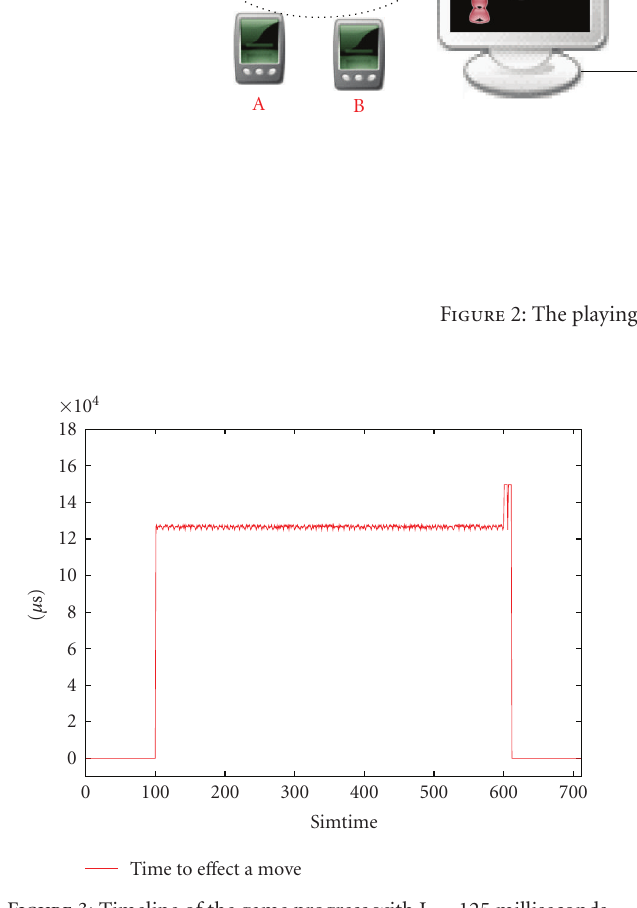
Figure 4: Timeline of the game progress with L = 125 milliseconds and PL =